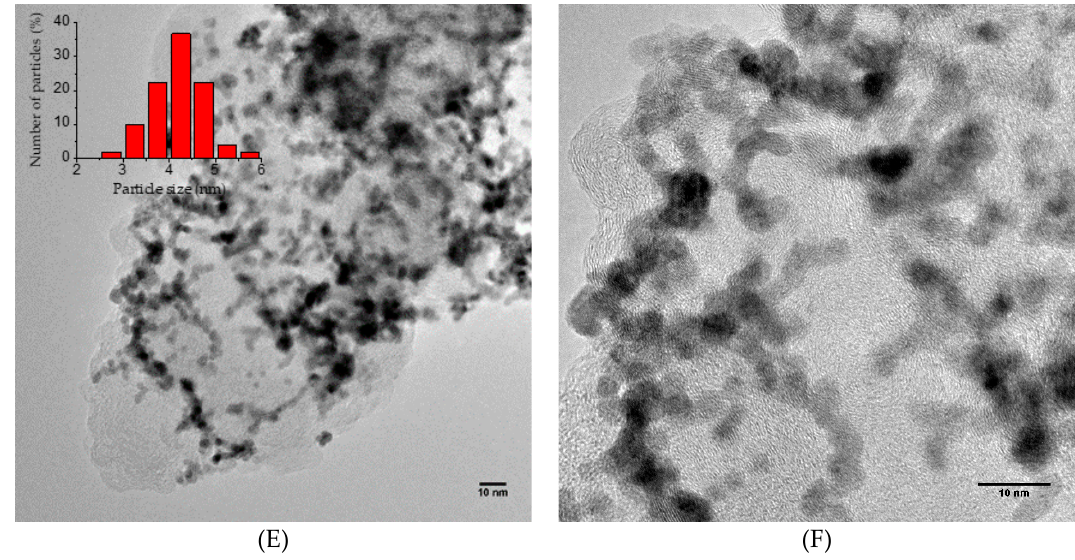
Figure 2. TEM images of Pt 20 /C ( A , B ), Pt 20 /SnO x8 /C ( C , D ) and Pt 20 /SnO x12 /C ( E , F ).